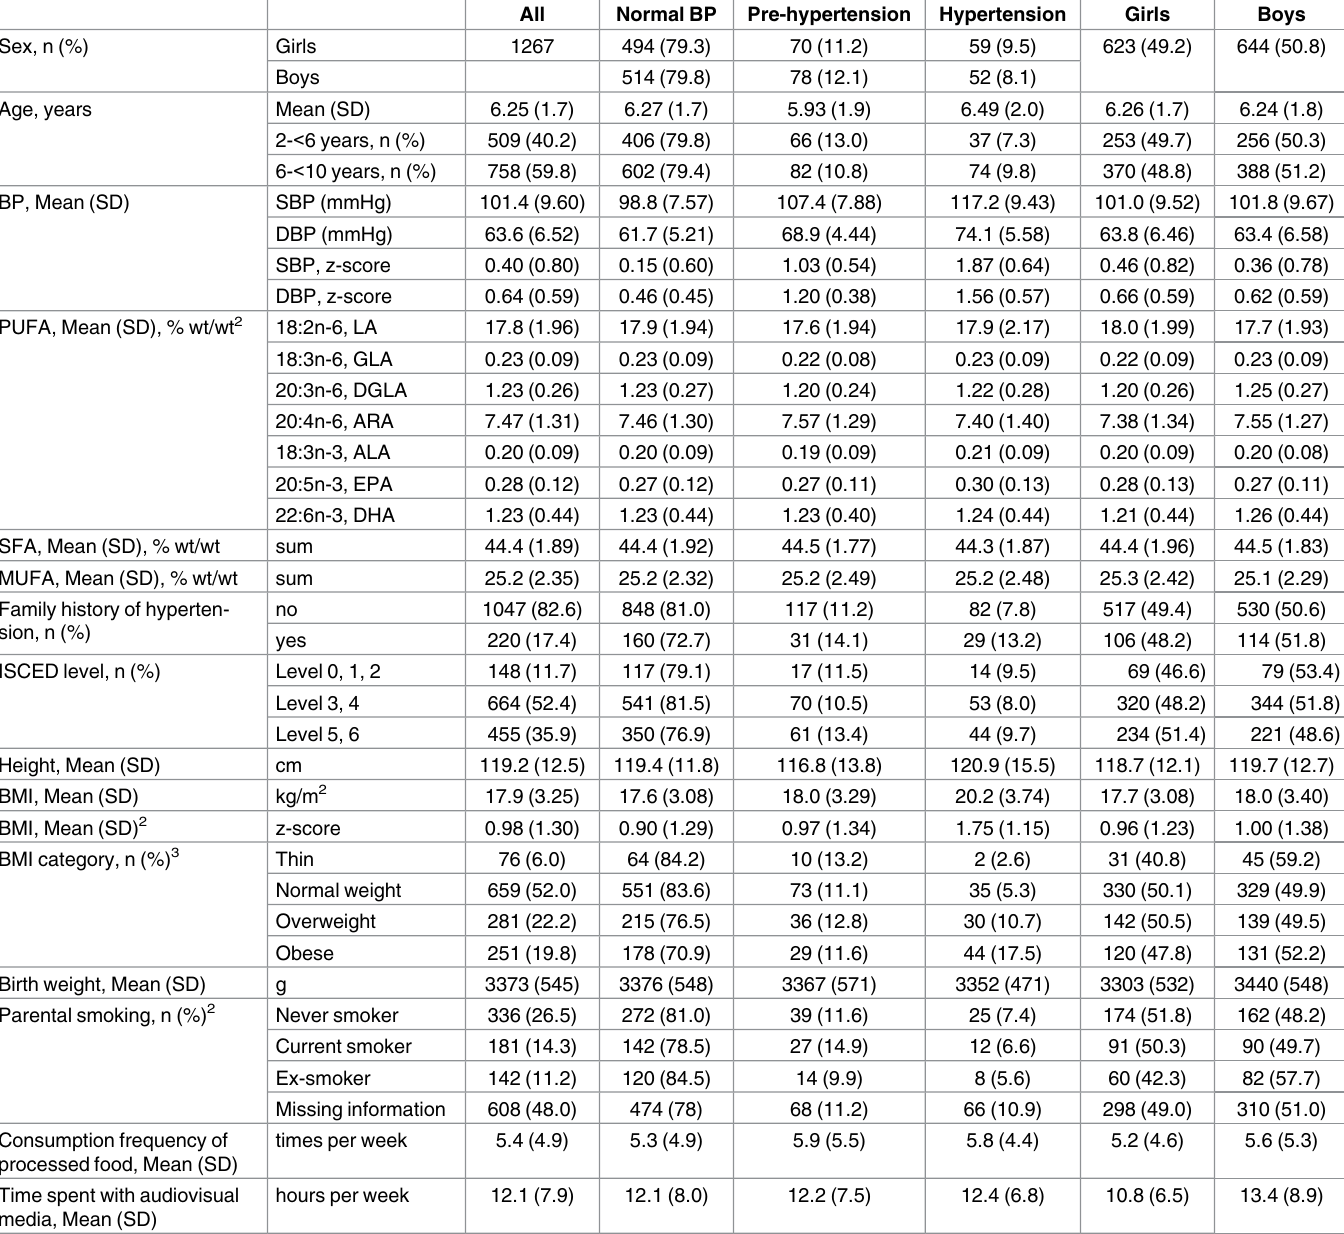
Table 1. Baseline characteristics of the study population by blood pressure category 1 and